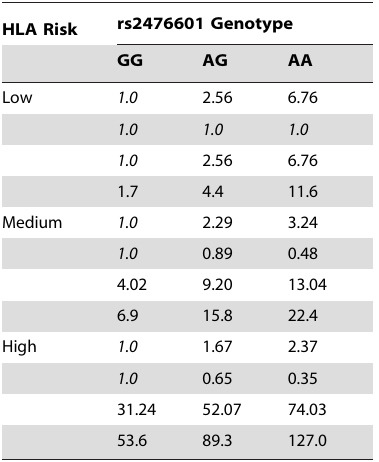
Table 1. T1D risk by HLA